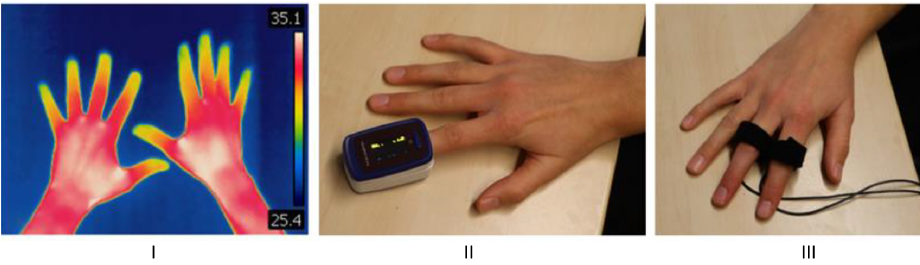
Figure 4. Used measurement tools for additional patient monitoring. Displayed are ( I ) the tempera- ture by Seek Thermal CompactPRO, ( II ) pulse oximeter (PULOX PO-200), and ( III ) skin